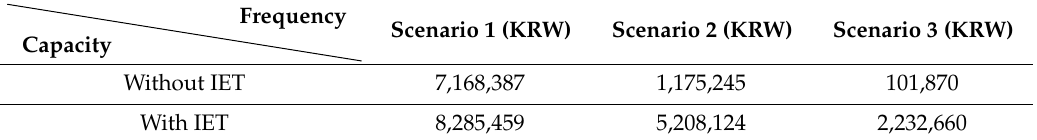
Table 7. Comparison of expected payo ff